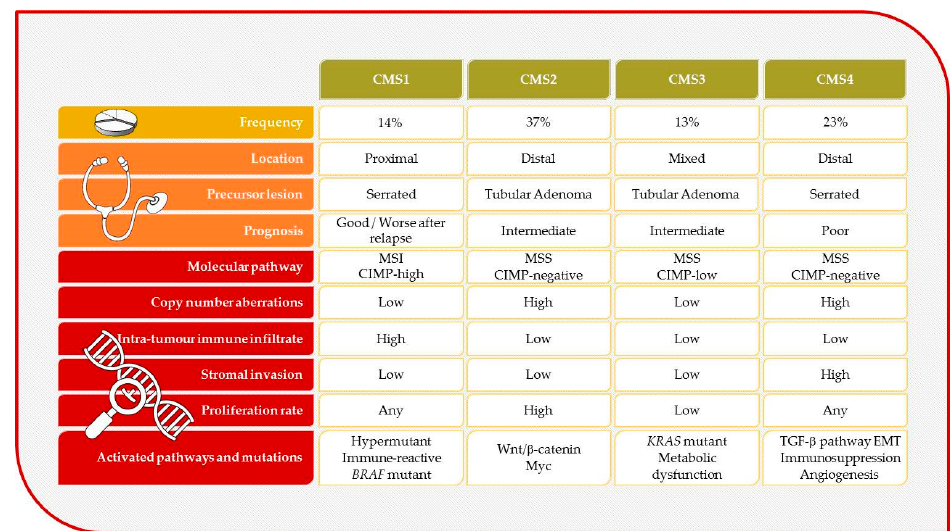
Figure 2. Characteristics of the molecular subtypes of colorectal cancer. CIMP: CpG island methylator phenotype; CMS: consensus molecular subtype; EMT: epithelial–mesenchymal transition; MSI: microsatellite instability; MSS: microsatellite stable.